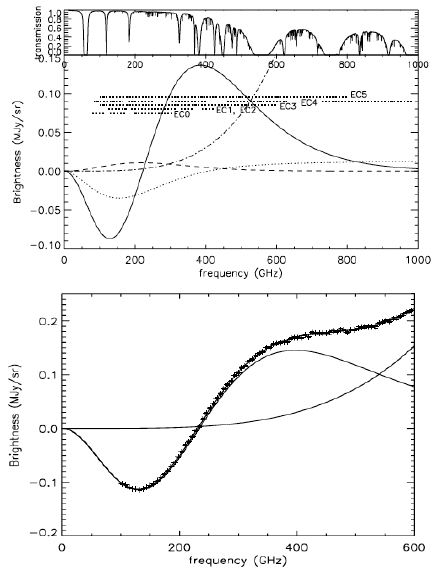
Figure 6: Top. Thermal SZE spectrum (contin- uous line in bottom panel), compared to the atmo- spheric transmission of a dry, cold, atmosphere (top panel, PWV= 0.5 mm), and to spectra of the non- thermal SZE (dotted line), of CMB anisotropy and kine- matic SZE (dashed line), and of dust anisotropy (dot- dashed line). The parameters of the different spectra are for τ th = 5 × 10 − 3 , T e = 8 . 5 keV, ∆ T CMB = 22 µ K, τ non − th = 10 − 4 , α = − 2 . 7, p 1 = 1 . 4 MeV/c, ∆ I d (150 GHz ) = 600 Jy. The frequency coverage of different experiments [25] is shown as dotted horizon- tal lines, labelled with the experimental configuration number. Bottom. Simulated data sets for the spectro- scopic configurations EC5 (differential cold FTS on a L2-orbit satellite, with cold